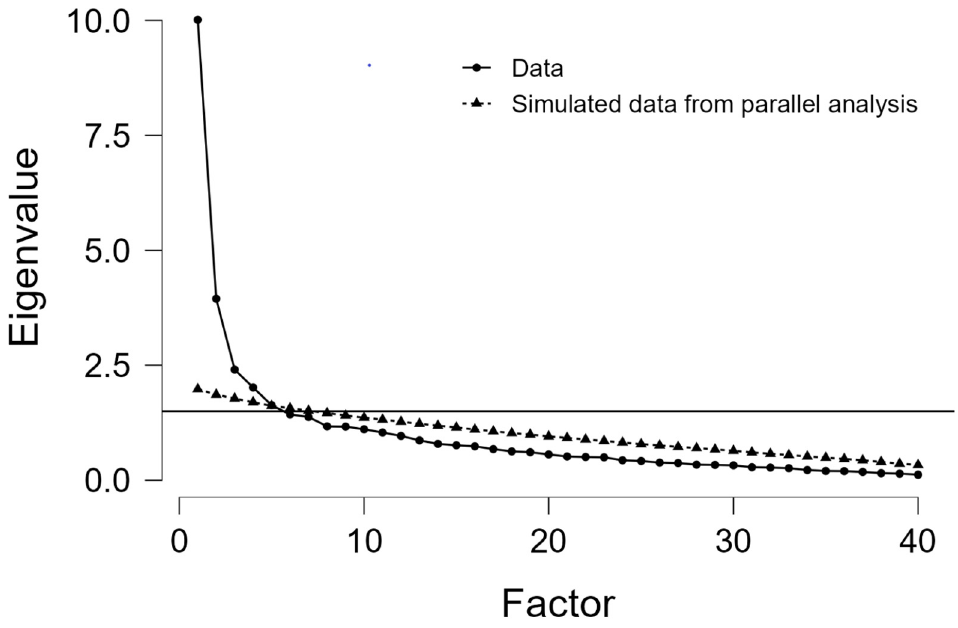
Figure 1. Scree plot of the eigenvalues of the factors identified in our questionnaire. Principal component analysis (PCA) simplified the complexity of high-dimensional data while retaining trends and patterns. After performing PCA and excluding the variables with loadings lower than 0.5, the final model contains 16 items (Tables 5 and 6) and confirms the factorial structure of the proposed questionnaire with the three dimensions identified by the exploratory factorial analysis. Table 5. Goodness of fit indices for the final model.